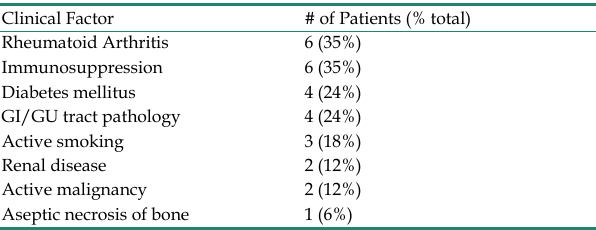
Table 3. Clinical Factors observed with Bacteroides PJI Clinical